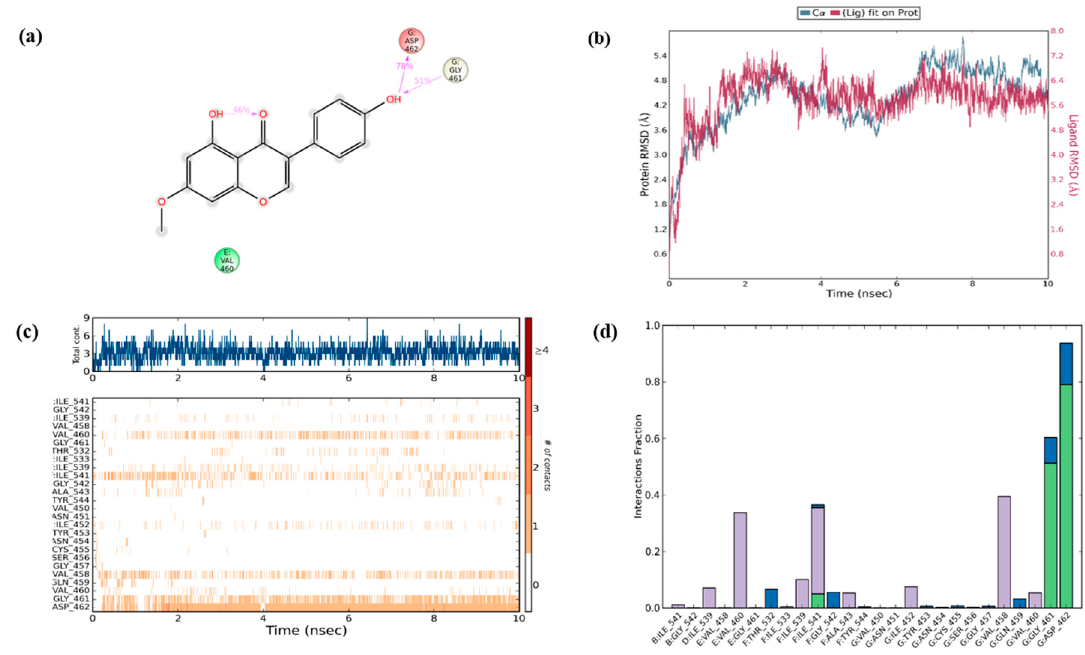
Figure 8. In silico molecular dynamics simulation. ( a ) Ligplot 2D summary showing the interaction of amino acids in the protein with the ligand. ( b ) The protein RMSD plot showing the ligand protein fit up to 10 ns during molecular dynamic simulation. ( c ) Protein–ligand interaction timeline with intensity of the each interacting amino acids during molecular dynamic simulation. ( d ) Interaction fractions of various residues during molecular dynamic simulation.